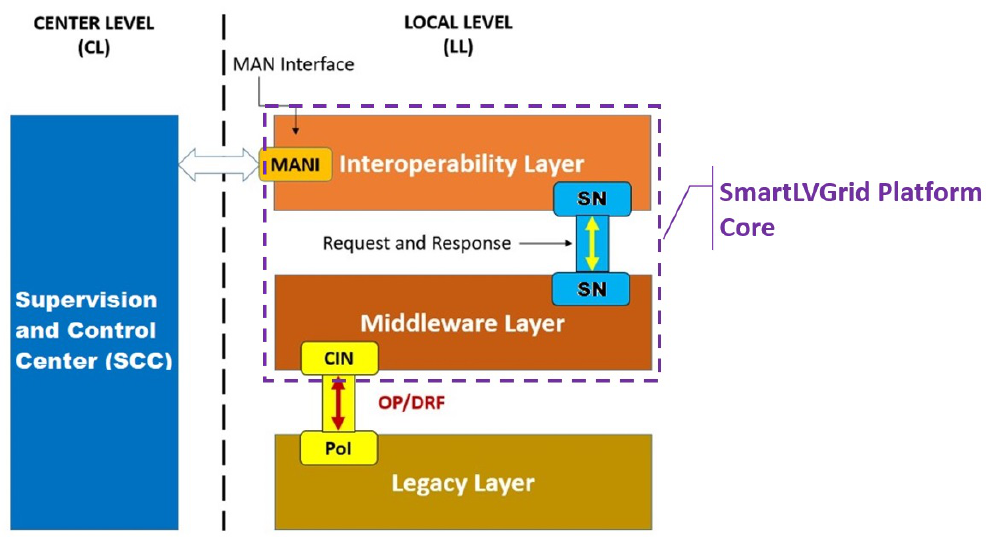
Figure 2. The SmartLVGrid stack in the context of the LV distribution